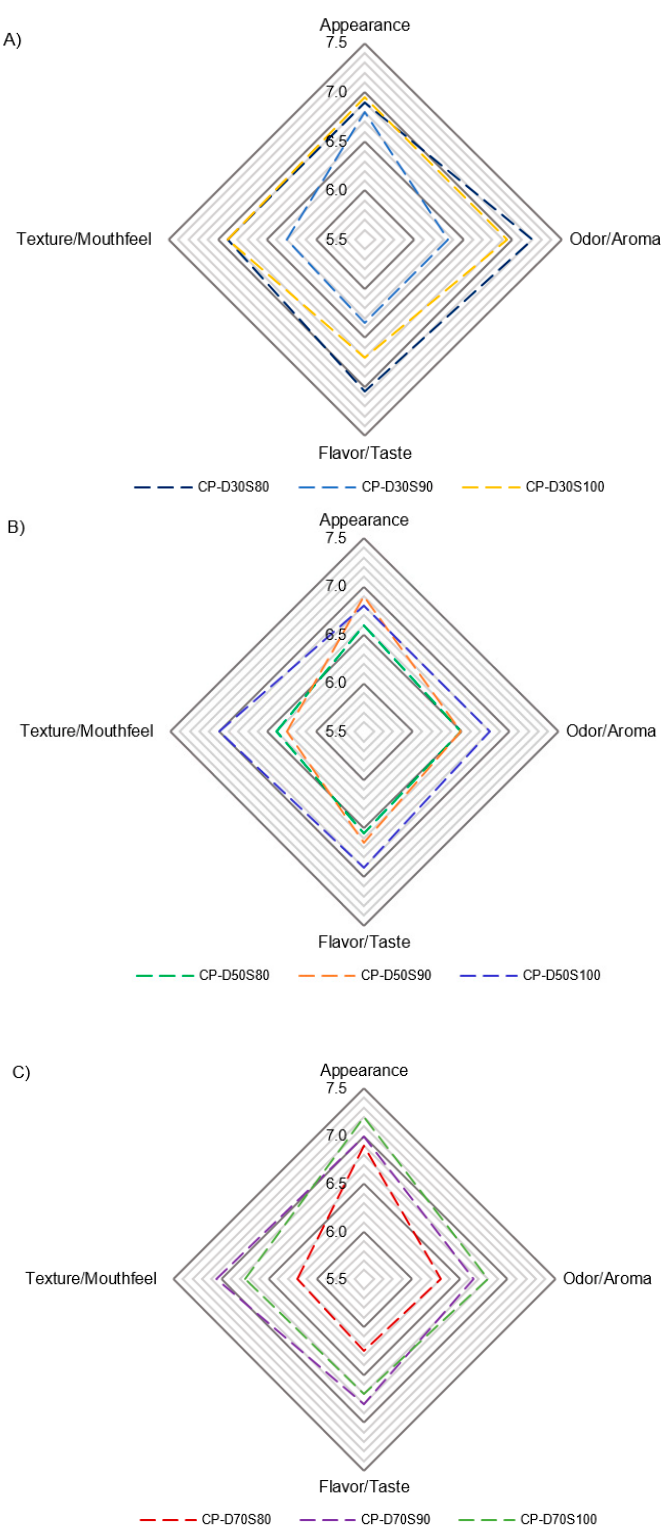
Figure 3. Effects of steeping temperature (80, 90, and 100 °C) on sensory properties of infusions obtained from flowers and leaves of Cunila polyantha dried at ( A ) 30 ◦ C for 43 h, ( B ) 50 ◦ C for 6 h, obtained from flowers and leaves of Cunila polyantha dried at ( A ) 30 °C for 43 h, ( B ) 50 °C for 6 h, and and ( C ) 70 ◦ C for 2 ( C ) 70 °C for 2 h.